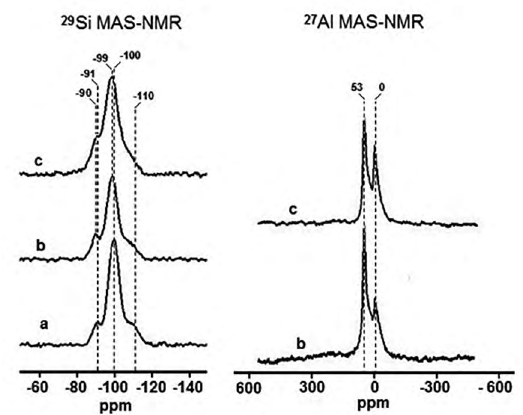
Figure 4. 29 Si-NMR and 27 Al-NMR spectra of (a) MCM-41, (b) Al-MCM-41(50), (c)